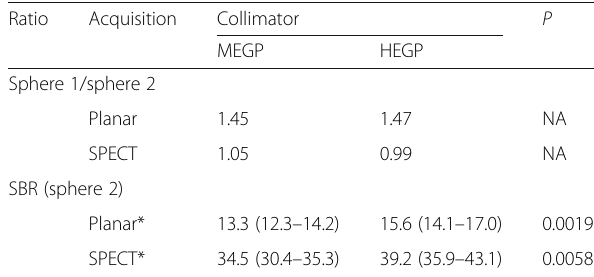
Table 2 Uptake ratio of sphere 1 to sphere 2 and sphere-to- background ratio (SBR) in a modified body phantom